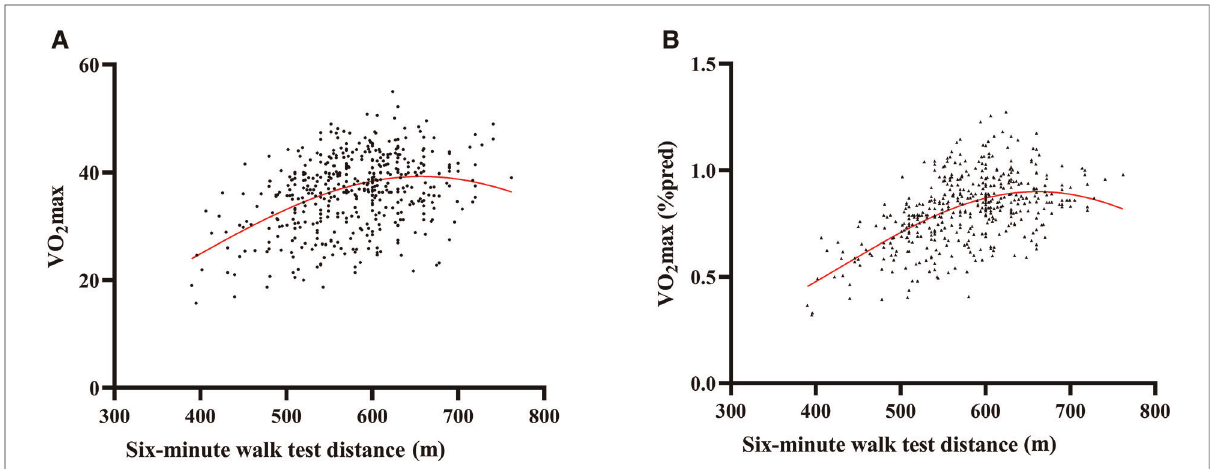
FIGURE 3 Scatter plots of the relationship between the six-minute walk test (6MWT) distance and VO2max of children and adolescents with congenital heart disease( A ); scatter plots of the relationship between the six-minute walk test (6MWT) distance and VO 2max (%pred) of children and adolescents with congenital heart disease ( B ). The red curvy lines in the scatter plots are nonparametric regression fi